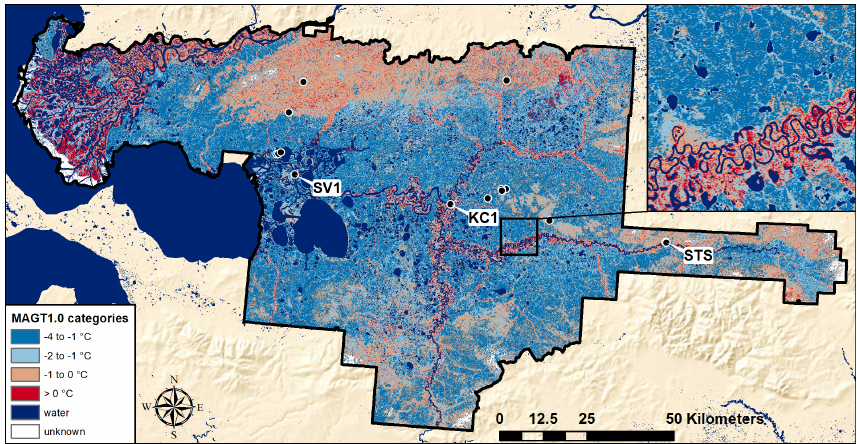
Figure 11. Map of MAGT at 1m depth for the SNWR including estimates for unmeasured ecotypes.